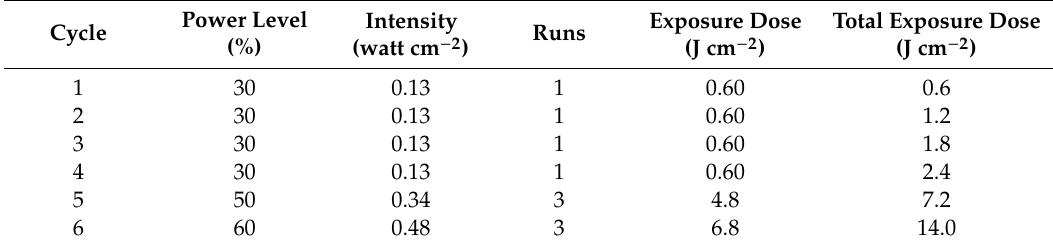
Table 1. Exposure profile applied in photobleaching experiments.